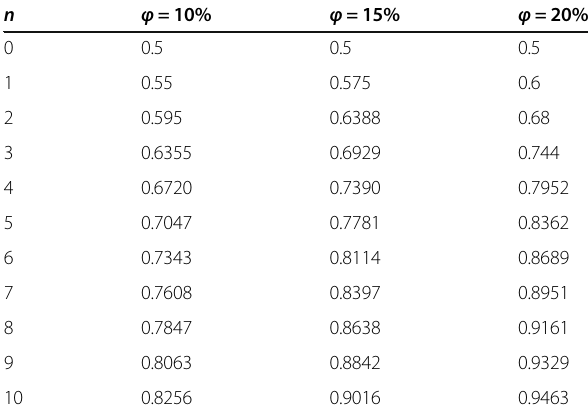
Table 4 Change of node 1 trust value in Case 1